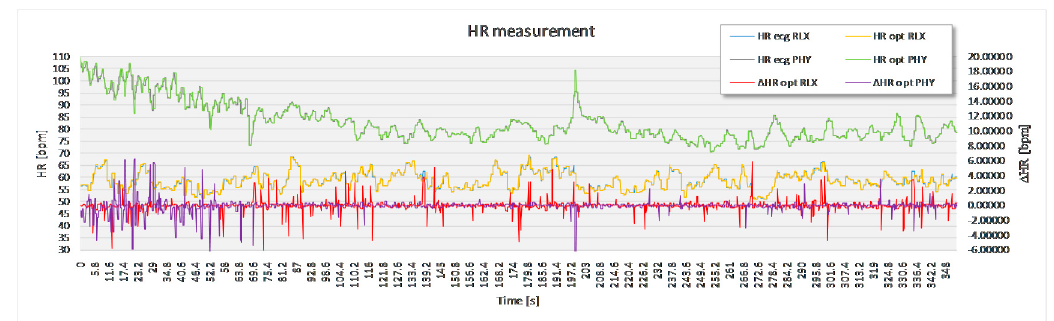
Figure 8. Recorded signal in laboratory experiment for subject 1.